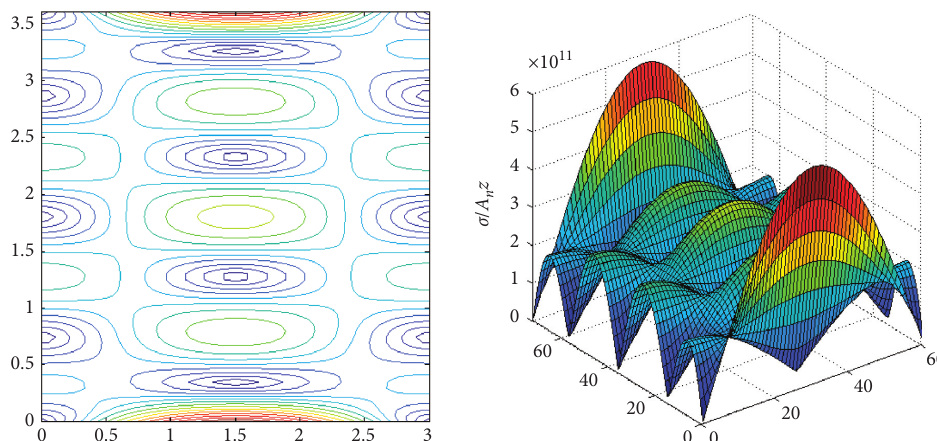
Figure 3: The maximum shear of the 5 th order mode